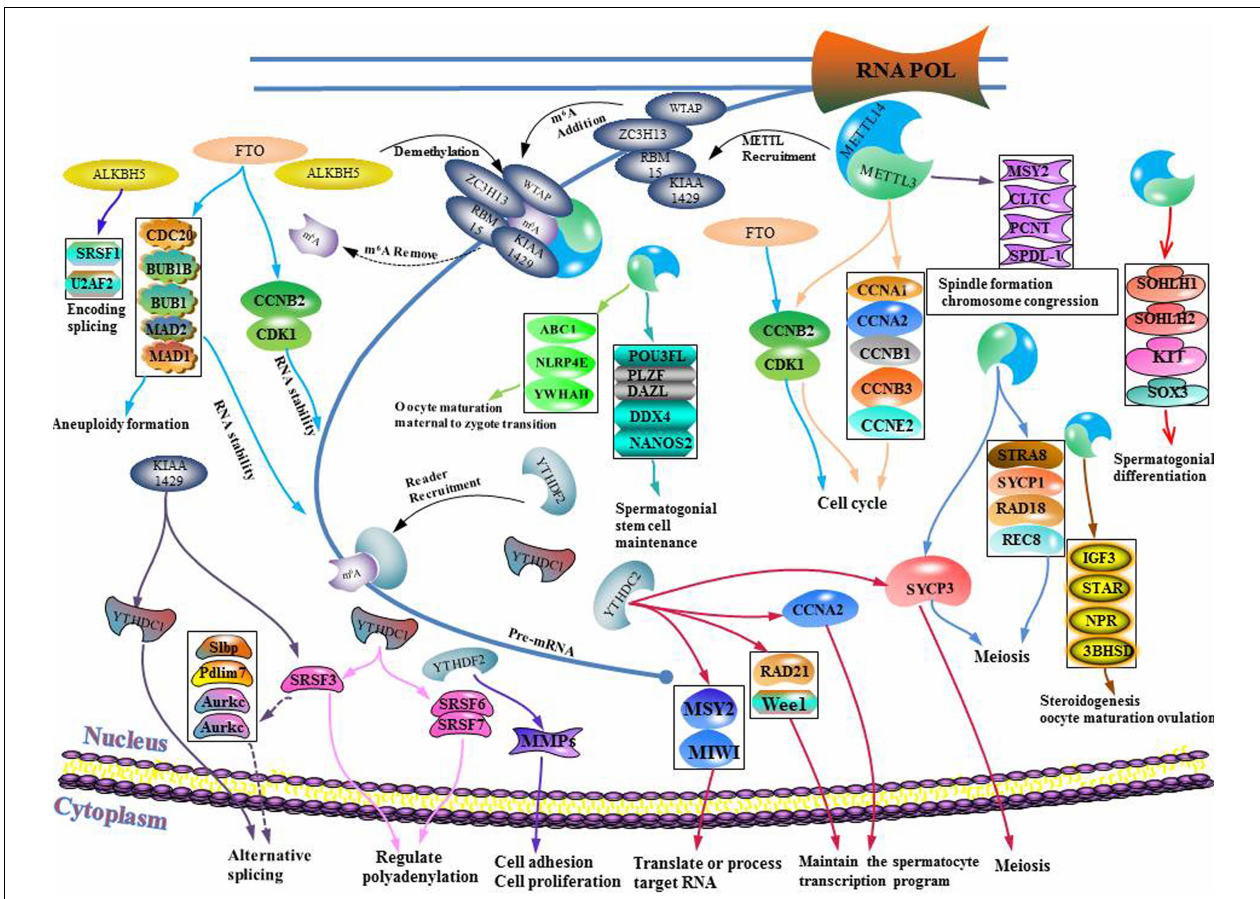
FIGURE 6 | Schematic illustration of the molecular mechanism between m 6 A writer, eraser, binding protein, and gametogenesis